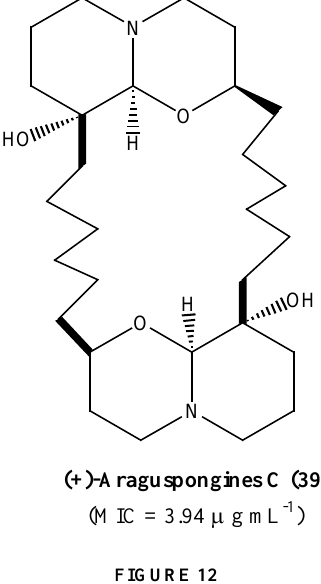
Ecteinascidins 770 40 and 786 41 (Fig. 13) were isolate by Suwanborirux and coworkers from Thai tunicate Ecteinascidia thurstoni [30]. This class of compounds showed potent cytotoxic activity with the ecteinascidin 743 42 under phase II clinical trials in the treatment of cancer[31]. Suwanborirux and his group found potent anti-TB activity against M. tuberculosis (H37Rv) in ecteinascidins 770 40 and 786